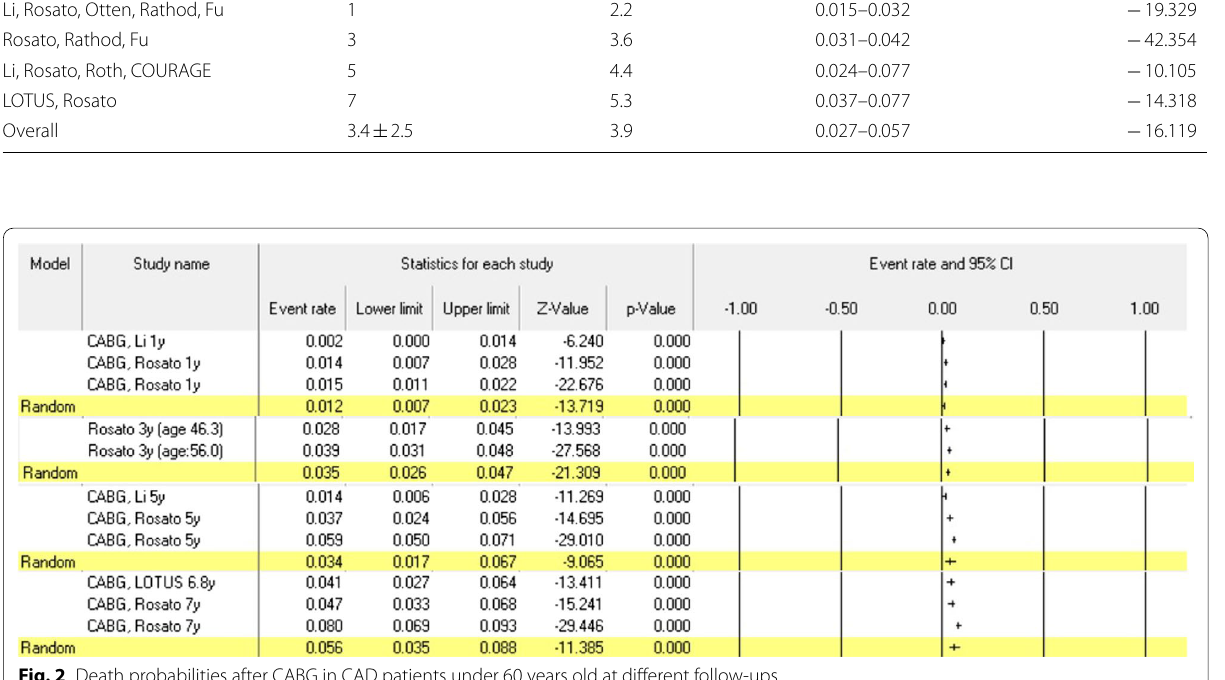
CABG: Coronary Artery Bypass Grafting; PCI: Percutaneous Coronary Intervention; MT: Medical Therapy Table 3 Death probabilities after revascularization (CABG or PCI) in CAD patients under 60 years old at different follow-ups Studies Follow-up (year)